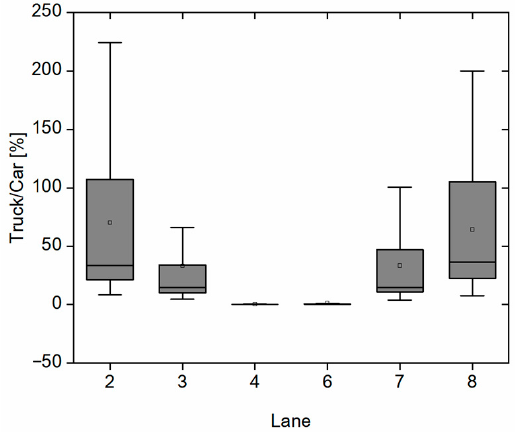
Figure 3. Relative proportion of truck and car in different lanes.